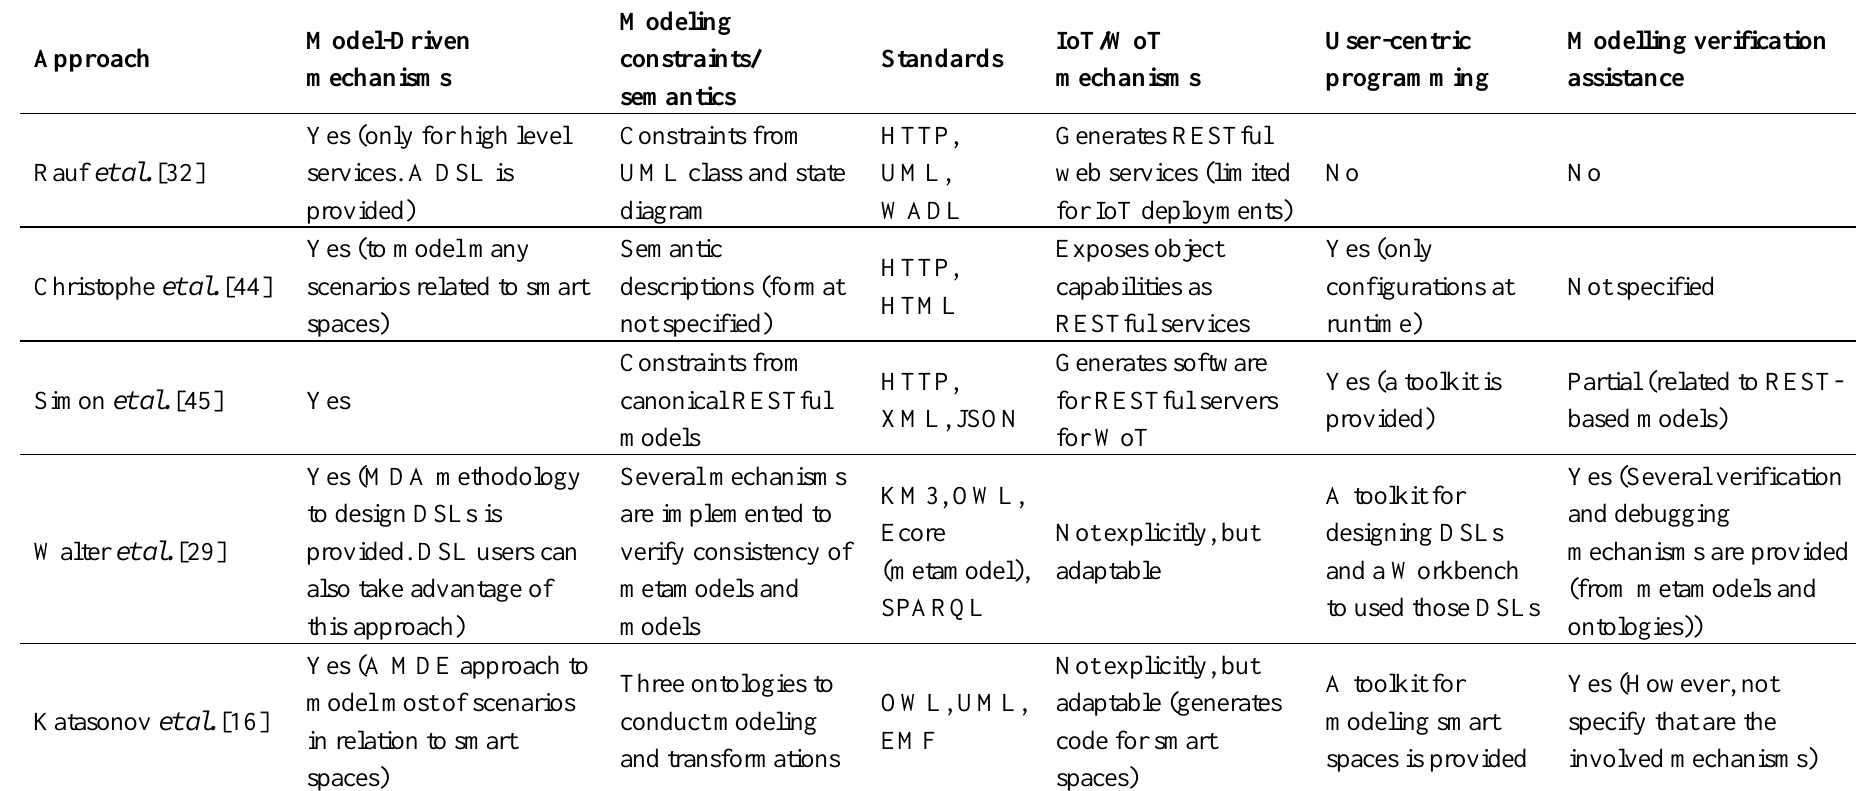
Table 1. Comparative table for different approaches dealing with development aspects of smart